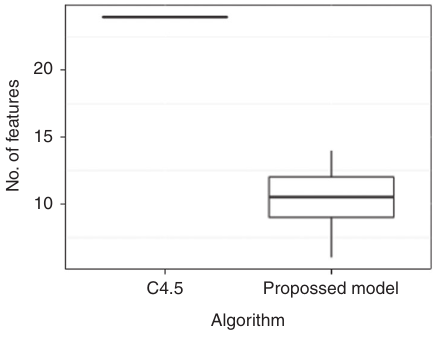
Figure 4. A comparison of the features number between the standard C4.5 classifier and the proposed model